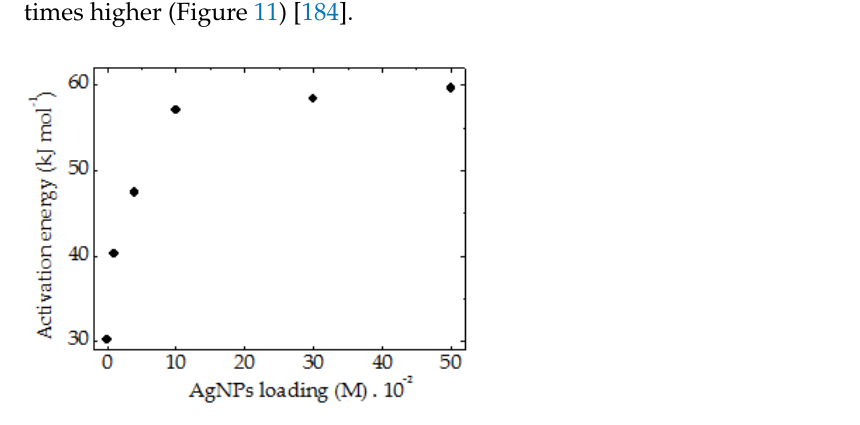
Figure 11. Activation energies for the thermal oxidation of unirradiated PVP/AgNPs hybrid [184]. Hyaluronic acid/chondroitin sulfate-based hydrogel represents another illustration of the involvement of high energy exposure for the preparation of high-performance hydrogel hybrids [185]. The proper irradiation dose for an appropriate gelation is 15 kGy, a low value, which permits the good retention of water and enzymes for cell treatment.